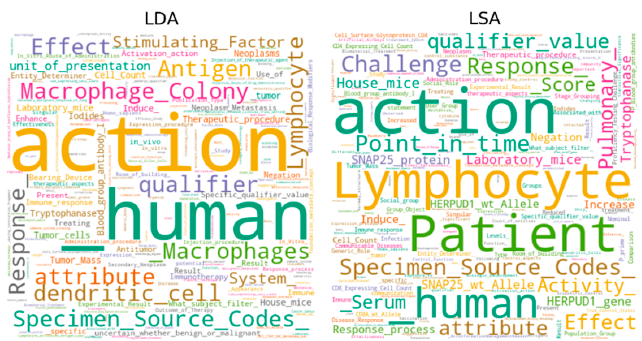
Figure 10. Word cloud of the top-1 topics on the DCE hallmark.